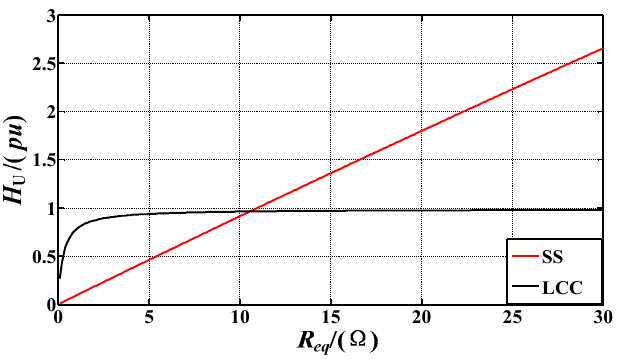
Figure 8. The comparison of the voltage gain between SS and LCC compensation.